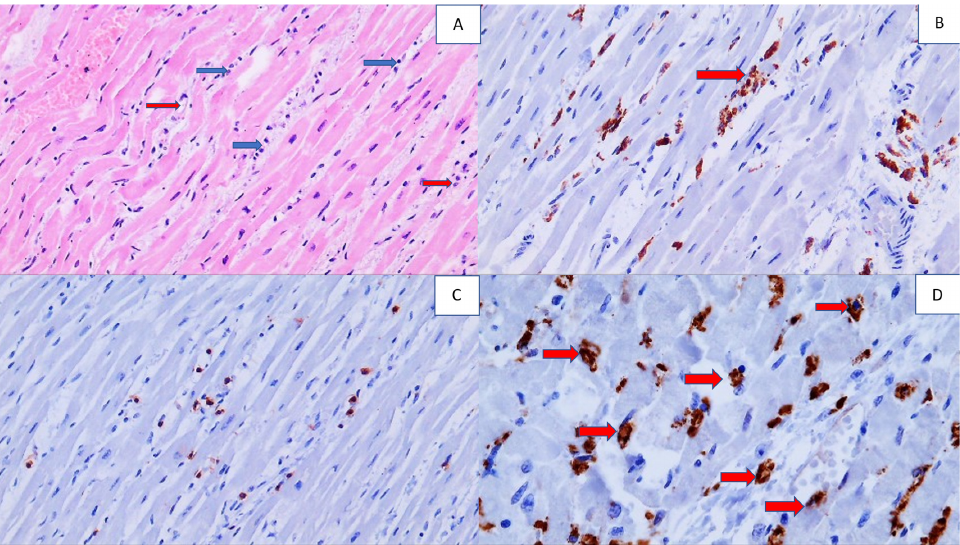
Figure 3. Histology and immunohistochemistry of the heart tissue of a COVID-19 patient with myocarditis. Photo ( A ) shows inflammatory cells (blue arrow) in edematous myocardial endomysium and the foci of myophagocytosis (red arrow) (HE, 200 × ). In Photo ( B ), immunohistochemically CD68-positive macrophages are present in the myocardium, being active in myophagocytosis (arrow), (DAB, 200 × ). Photo ( C ) shows immunohistochemically brown-stained CD3-positive T lymphocytes in the endomysium (DAB, 100 × ). Photo ( D ) shows an immunohistochemically positive reaction for MPO of PMNs in myocardial blood vessels and their spread in perivascular space (arrows), (DAB, 400 × ).